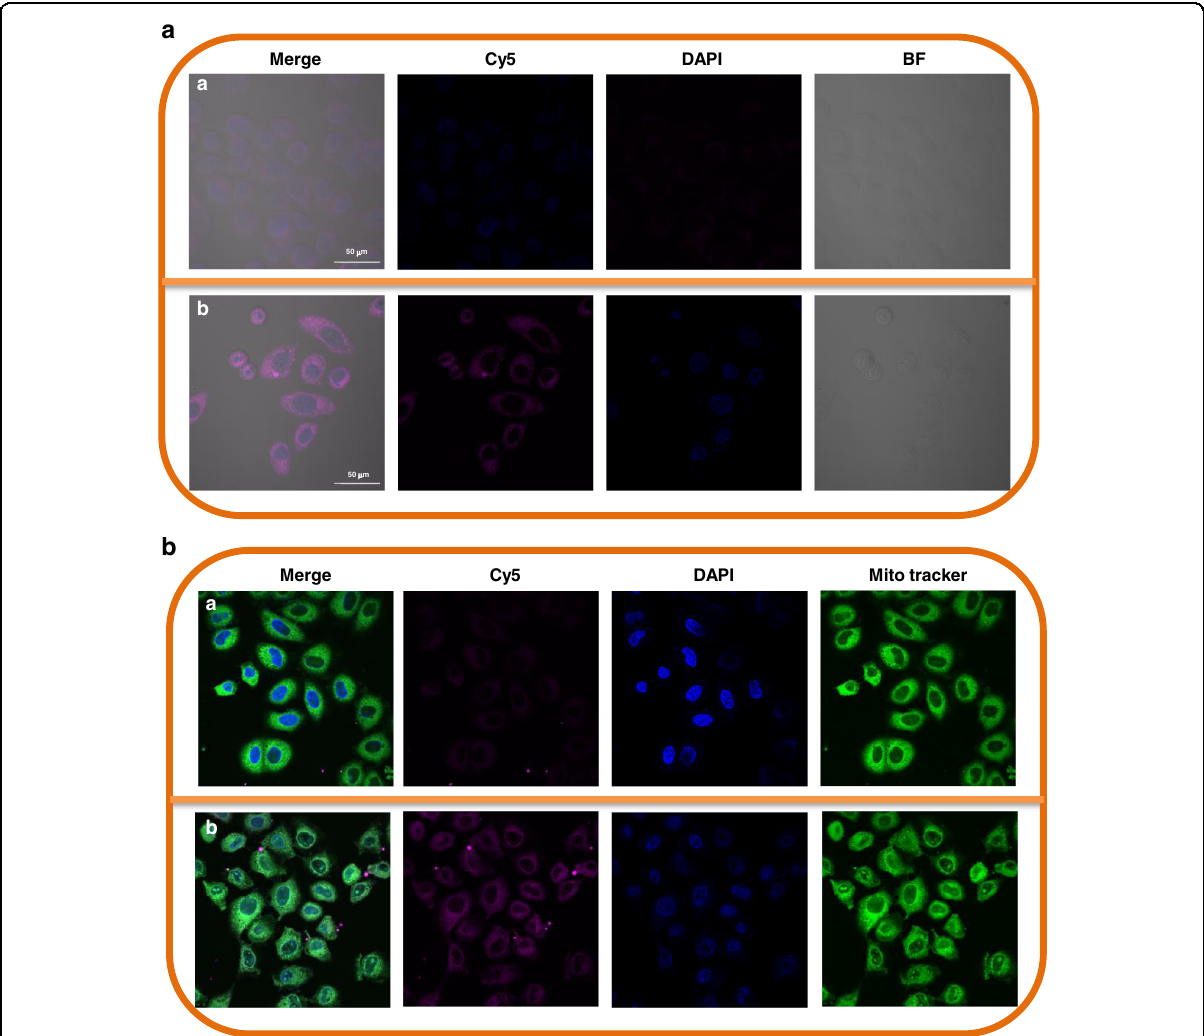
Fig. 6 The pH-sensitivity and distribution in lysosome and mitochondria of Cy5-B@PDA. a CLSM images of HCT-116 cells cultured with Cy5- B@PDA at different pH environments after 3 h (Scale bar: 20 μ m): (a) pH 7.4; (b) pH 6.5. b The localization of Cy5-B@PDA in mitochondria when HCT- 116 cells were incubated with Cy5-B@PDA at 37 °C: (a) 30 min; (b) 3 h (Scale bar: 50